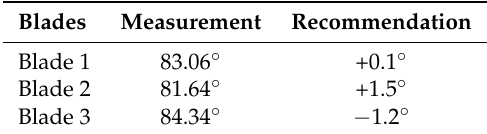
Table 1. Blade angle measurements and consequent